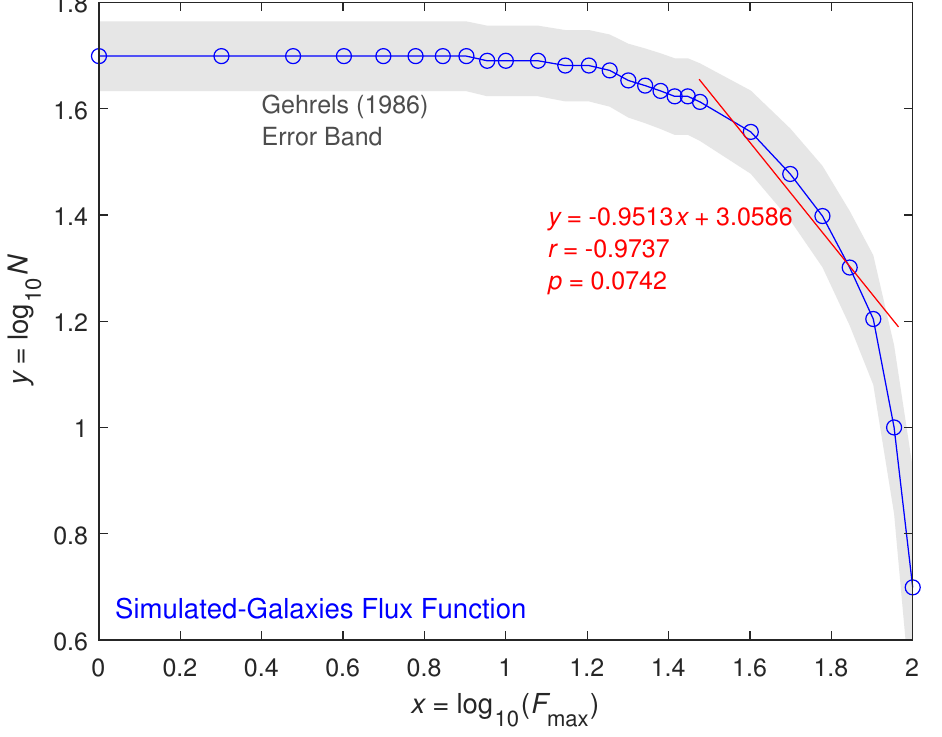
Figure 13. A typical log N -log F max diagram derived from one simulation of 50 “galaxy” samples. The measured slope at intermediate F max values (30–80) is m = − 0.9513 ± 0.1113 ( 1 σ )